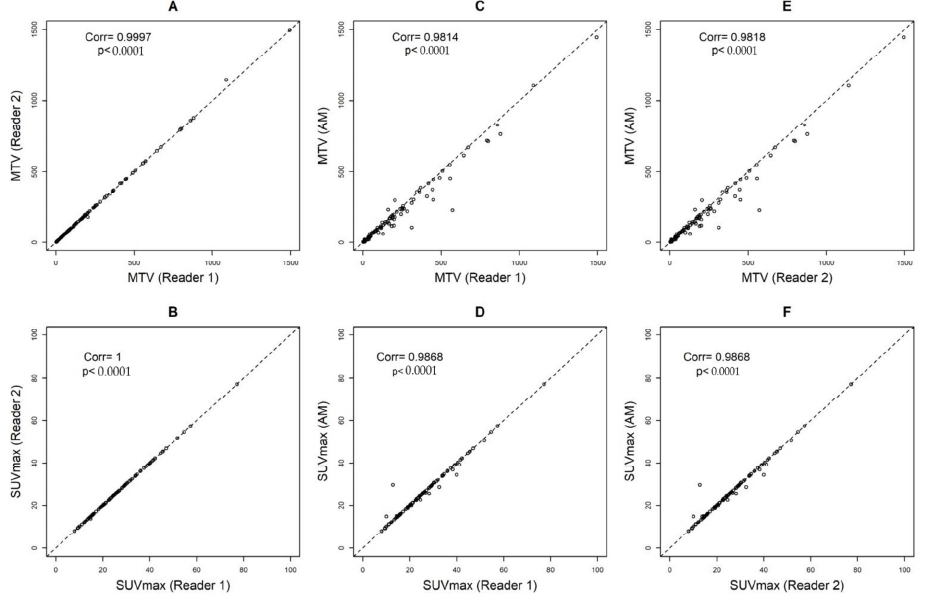
Figure 3. Pearson’s correlation coefficients calculating metabolic tumor volumes (MTV) with a threshold of 41% and SUVmax between Reader 1 and Reader 2 ( A , B ), Automated Method (AM) approach and Reader 1 ( C , D ), and AM and Reader 2 ( E , F ).